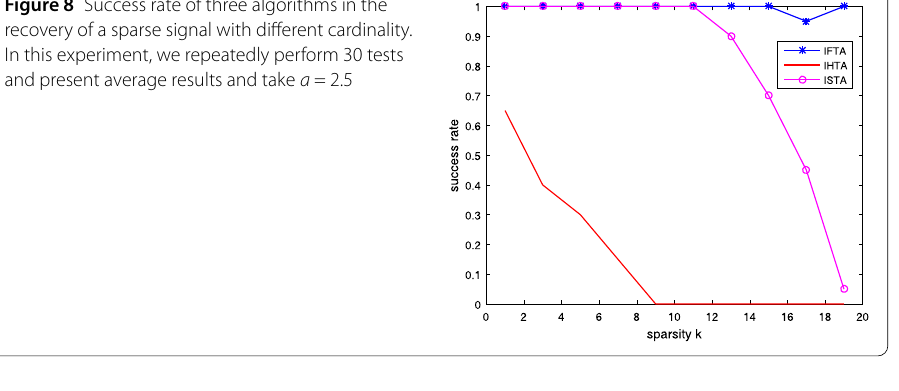
Figure 9 Relative error between the solution x ∗